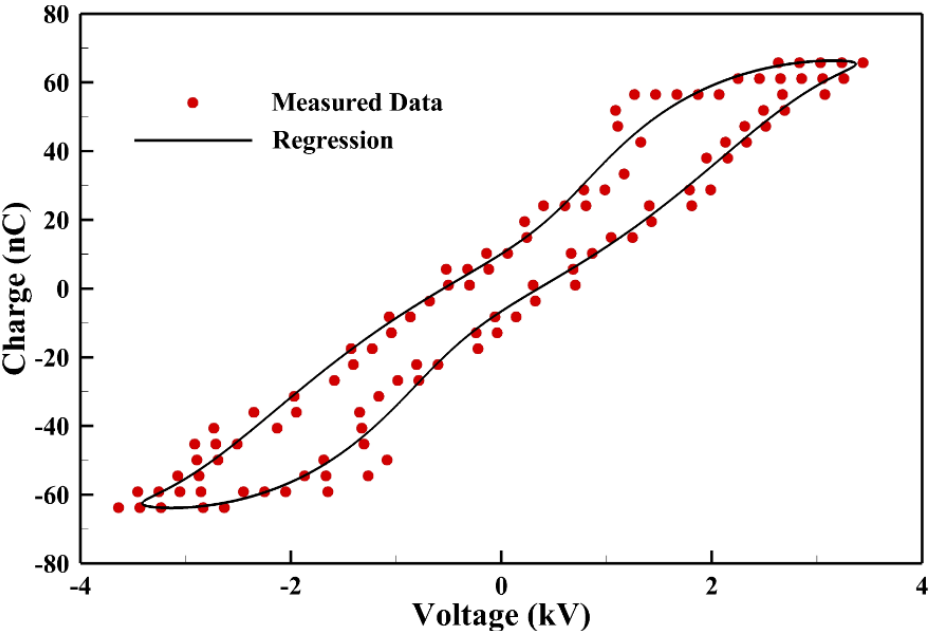
Appl. Sci. 2020 , 10 , x FOR PEER REVIEW Figure 5. The Lissajous curve of a typical discharge cycle to evaluate the measured power consumption.